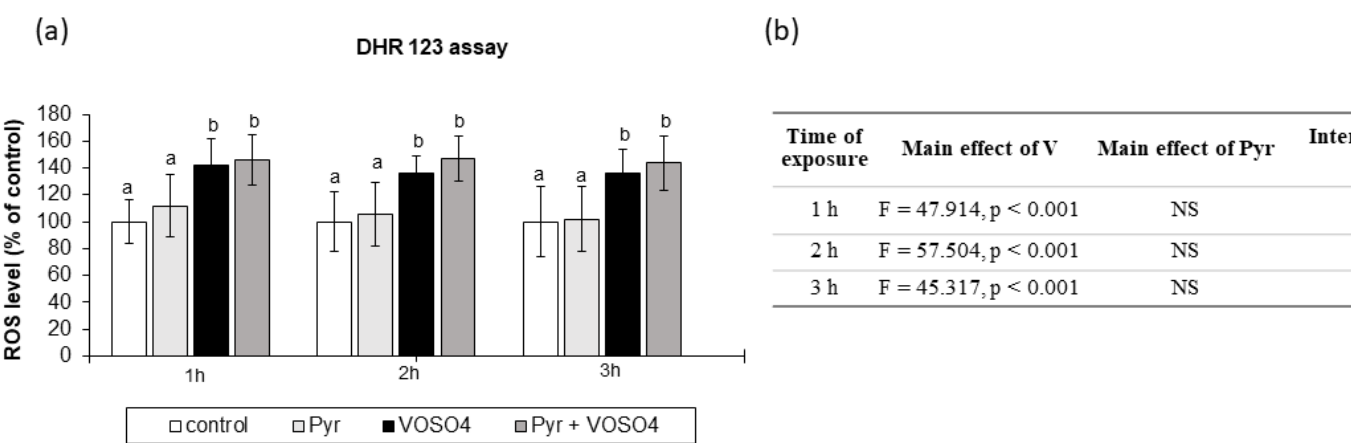
Figure 3. Effects of vanadium and/or pyruvate on ROS accumulation in CHO-K1 cells detected by the DHR123 assay. The DHR123-preloaded cells were incubated in DMEM/F12 medium without (control) or with 100 μM VOSO 4 in the presence or absence of sodium pyruvate (Pyr) (4.5 mM) for 1, 2, and 3 h. ( a ) Intracellular accumulation of ROS on the basis of RH-123 fluorescence emissions expressed in percentage. Data represent the mean ± SD of quadruplicate determinations of 3 distinct experiments. Means at the same time point followed by a common letter are not significantly different. Data were analysed by one-way ANOVA followed by Tukey’s post-hoc test. ( b ) Results of the two-way ANOVA analysis of RH-123 fluorescence emissions after 1-, 2-, and 3-h exposure to V (as VOSO 4 ) and Pyr (pyruvate); NS: no significant effect.